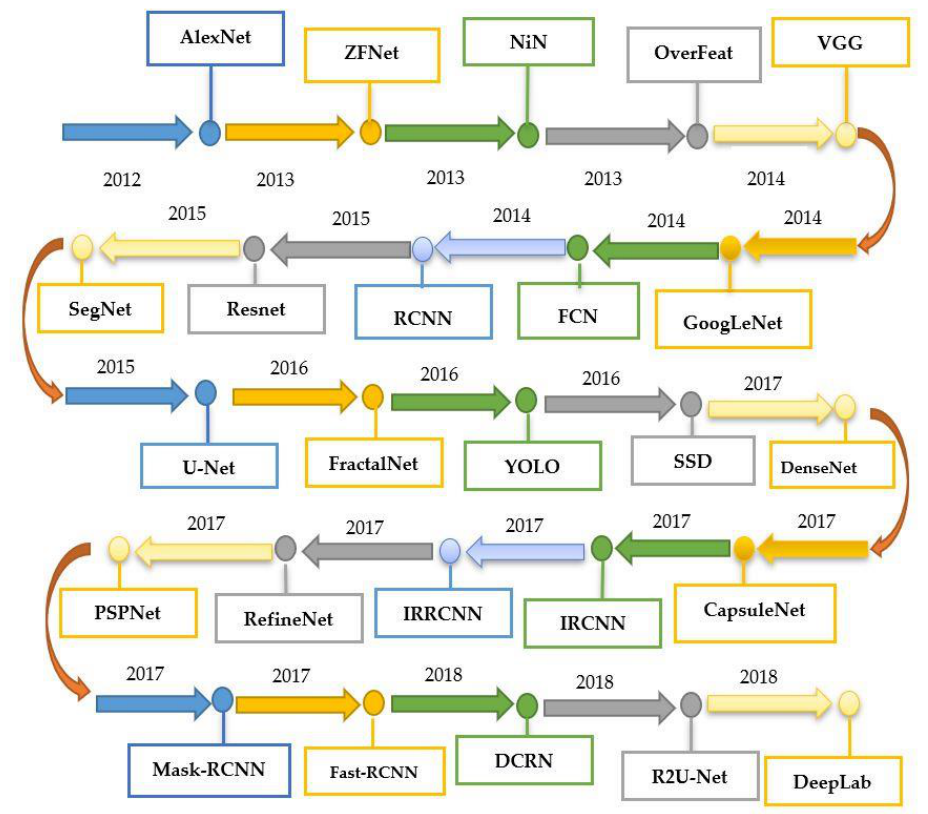
Figure 3. Summary of the evolution of various deep learning models from 2012 until now.